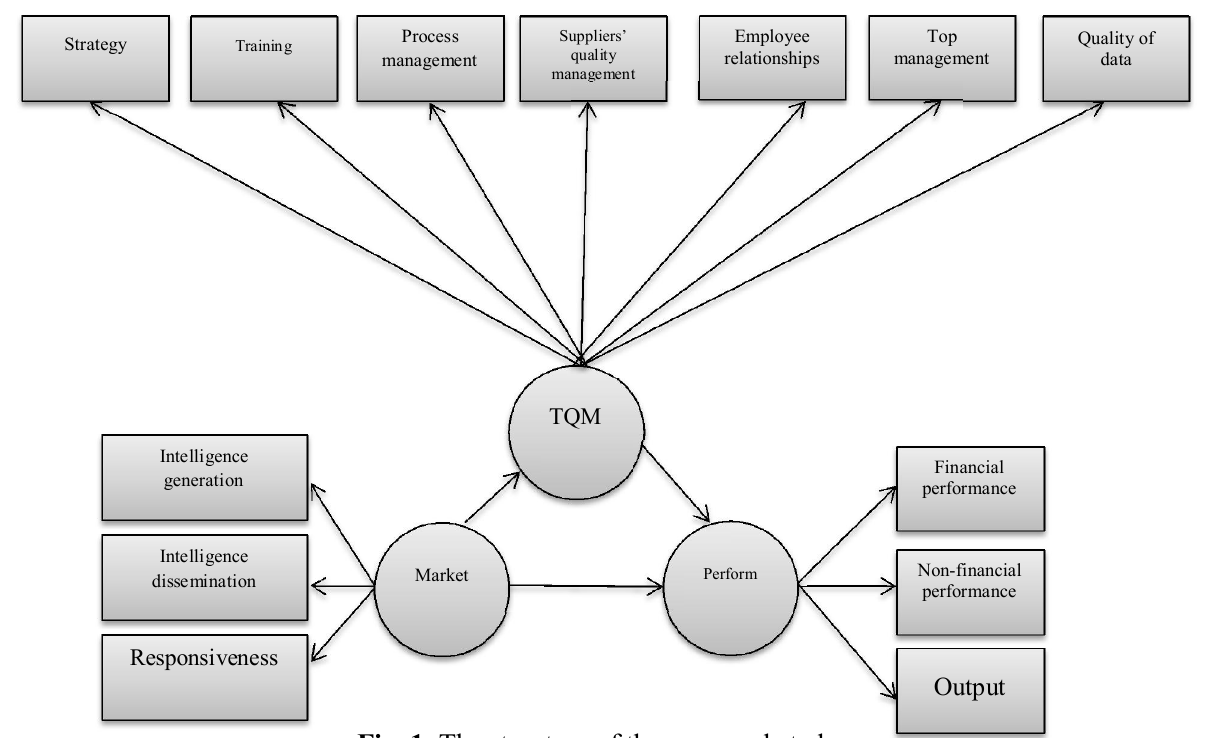
Fig. 1. The structure of the proposed